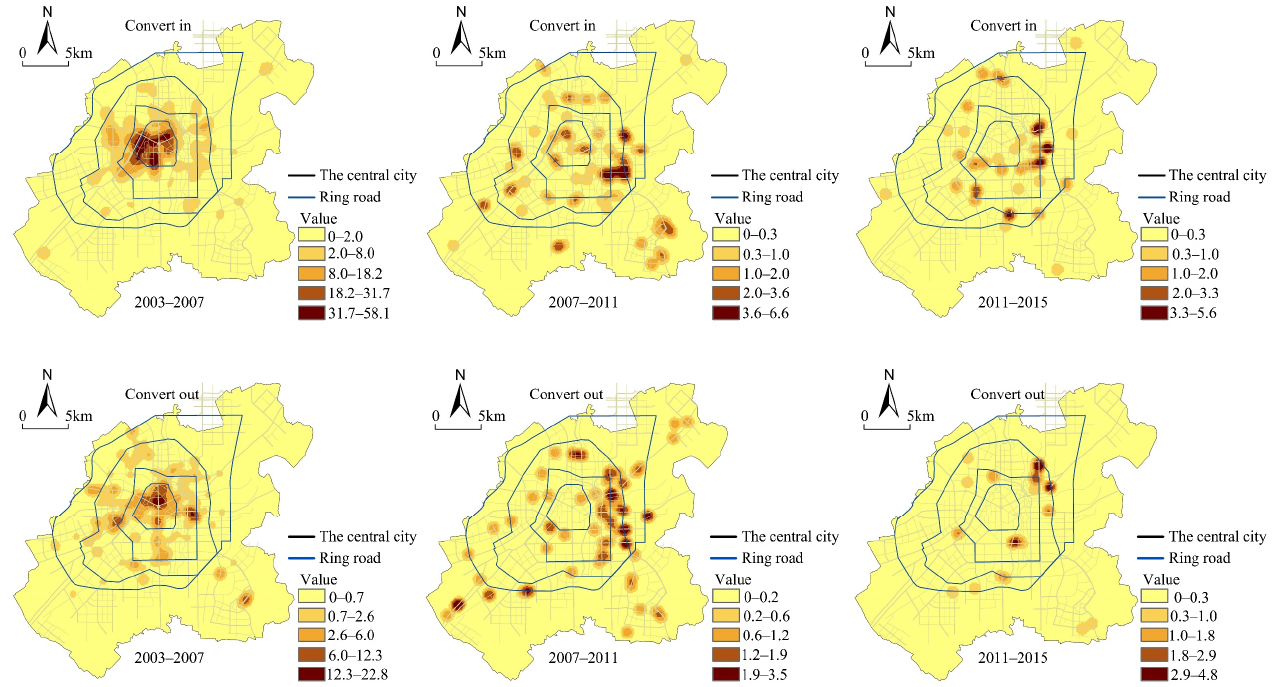
Figure 9. Kernel density map of commercial land conversion in different periods.